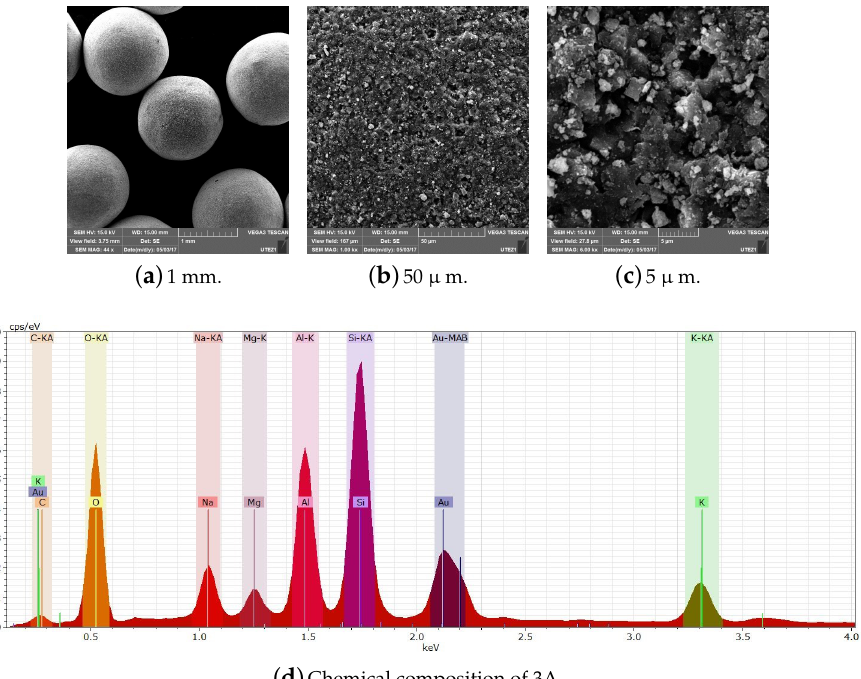
Figure A13. Scale display through SEM and chemical composition of Type